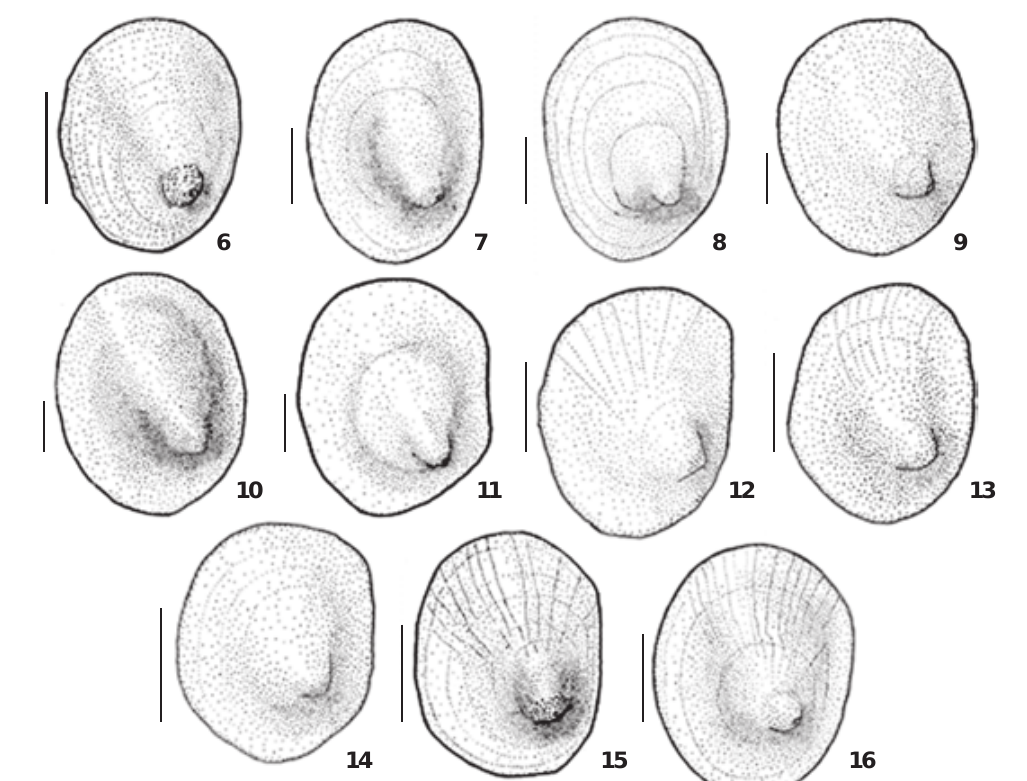
Figures 6-16. Gundlachia ticaga from four sites in Ilha Grande, Angra dos Reis, Rio de Janeiro. Dorsal view of shells showing morphologi- cal variation. (6-8) patterns I-III, Vila do Abraão shells; (9-11) patterns I-III, Provetá shells; (12-14) patterns I-III, Parnaioca shells; (15-16) patterns I-II, Praia do Sul shells. Scale bar = 1 mm. Table I. Morphological variations visually observed on shells of G. ticaga within four sites on Ilha Grande, state of Rio de Janeiro. (N) Number of shells and percentage in parenthesis. Locality Radial lines Other